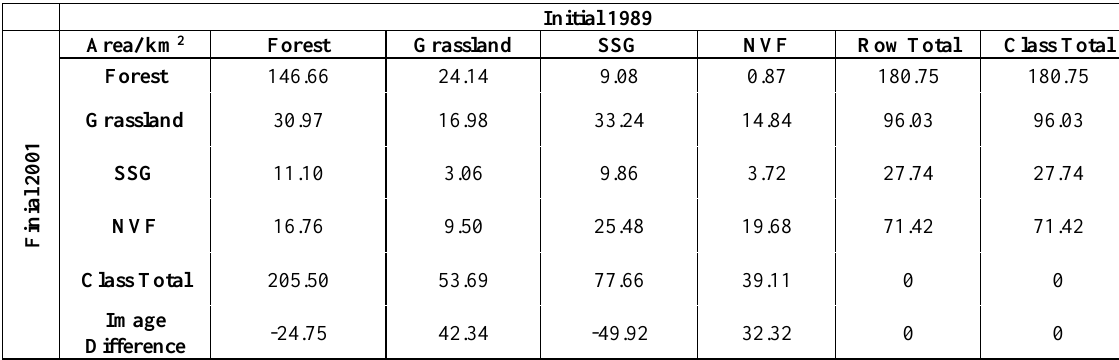
Table 4 Change detection